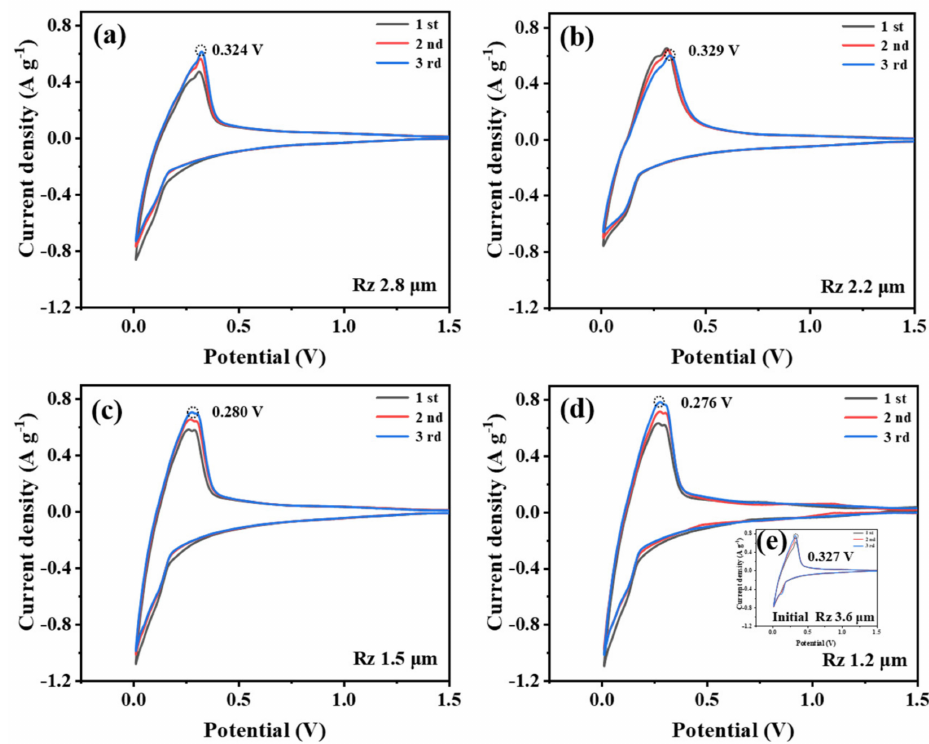
Figure 4. Initial three CV curves recorded at the scan rate of 0.5 mV s − 1 for batteries using electrolytic copper foils with different roughness: ( a ) CF-2.8-graphite, ( b ) CF-2.2-graphite, ( c ) CF-1.5-graphite, ( d ) CF-1.2-graphite, inset: